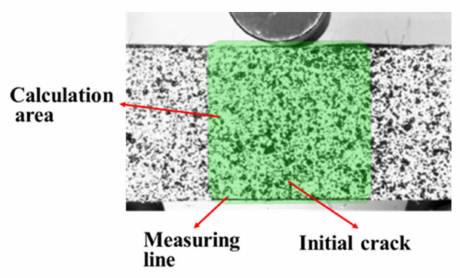
Figure 3. Measurement line of the initial crack area.